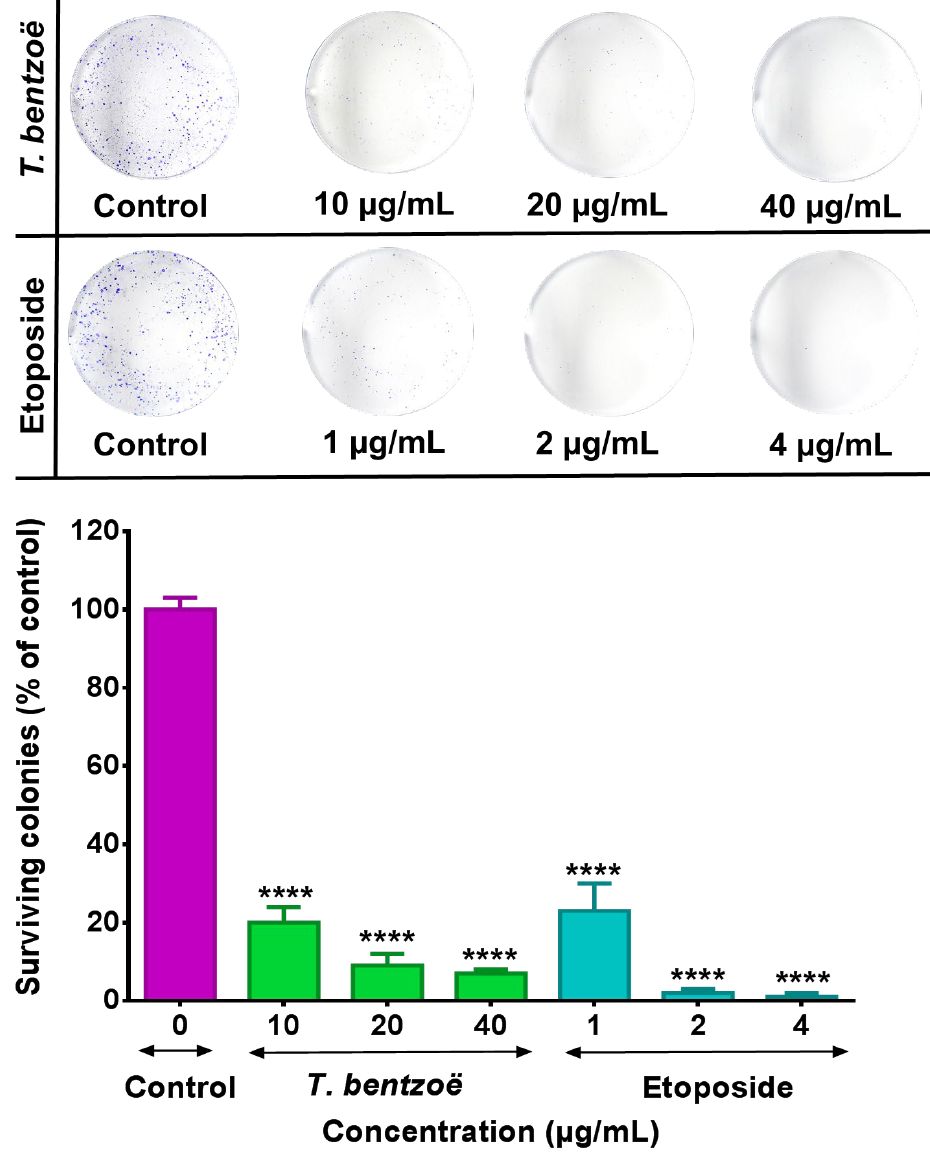
Figure 1. HepG2 cells were treated with the indicated concentrations (µg/mL) of test extracts for 48 h and subsequently allowed to grow into colonies for 14 days. After 14 days, the colonies were stained with 0.1% crystal violet and the images of the wells were captured using a digital camera. The colonies were counted using Image J software. Each experiment was performed three times. Asterisks represent significant differences between extract treatments and untreated control, **** p ≤ 0.0001.